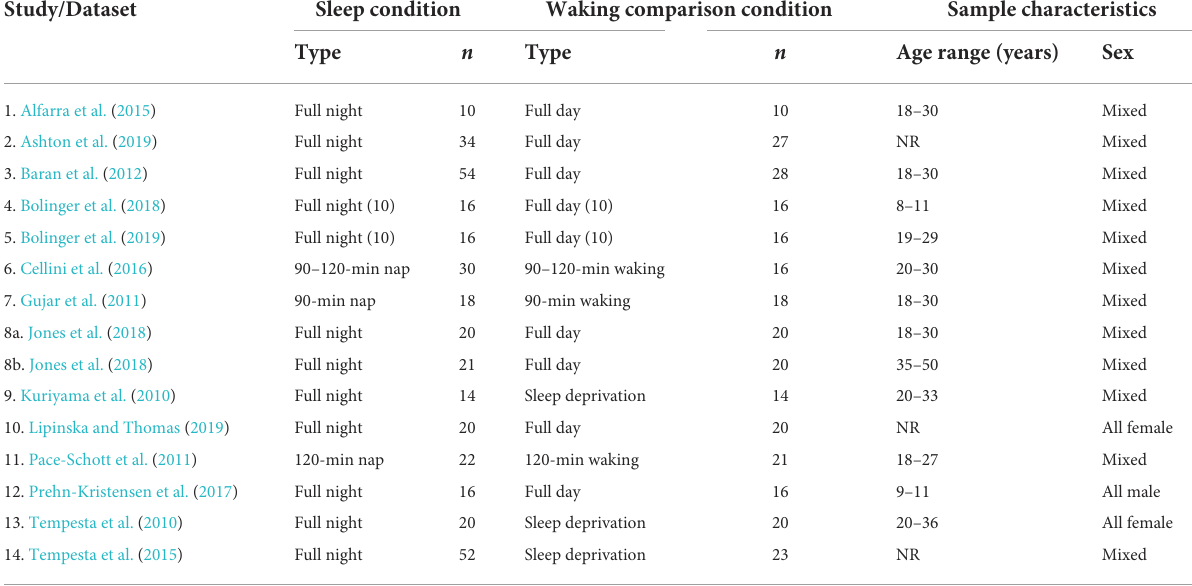
TABLE 1 Datasets included in the meta-analysis: Study design, conditions, and sample characteristics ( N = 14).